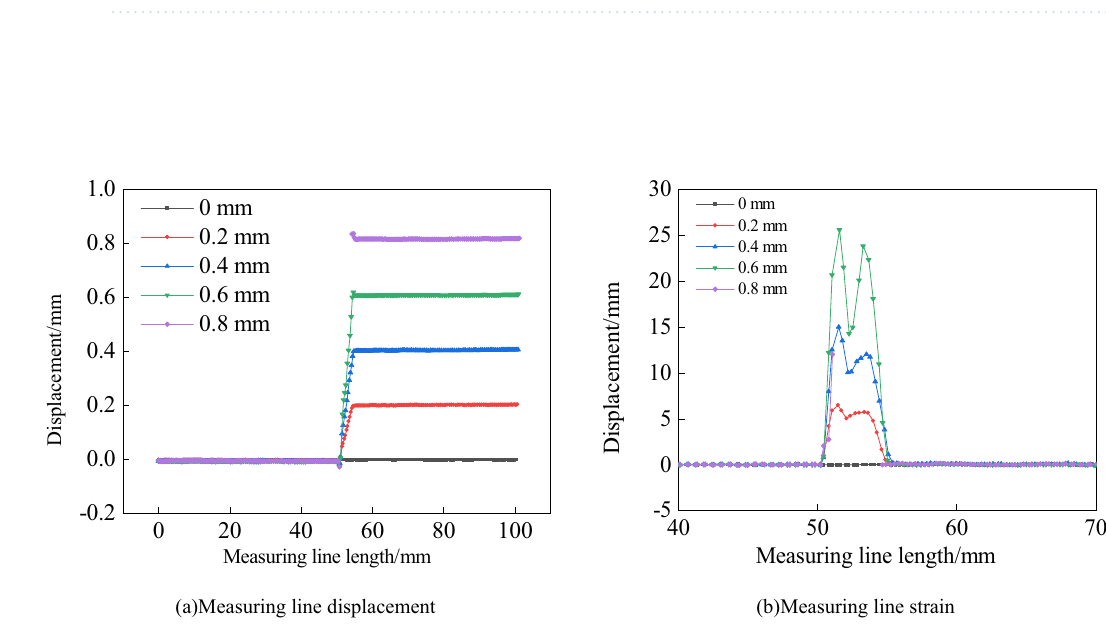
Figure 8. DIC measurement line test